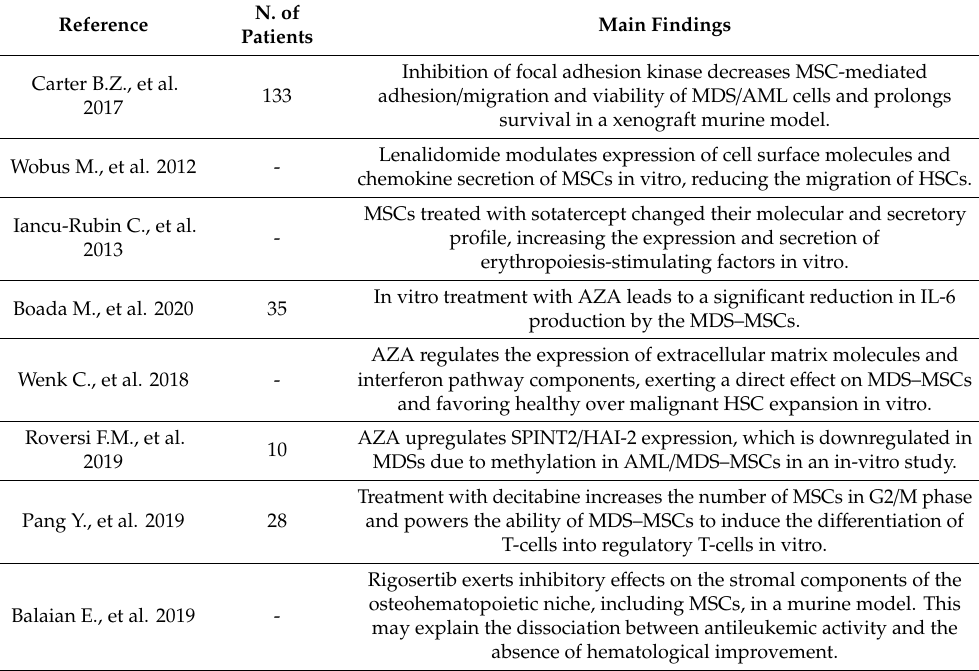
Table 4. Mesenchymal stem cells (MSCs) as a therapeutic target in myelodysplastic syndromes